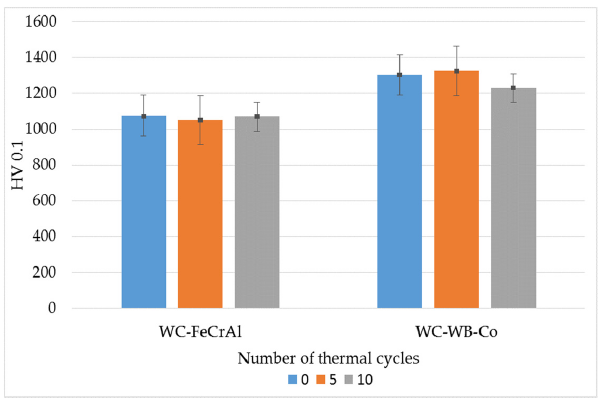
Figure 4. Microhardness of the coatings.